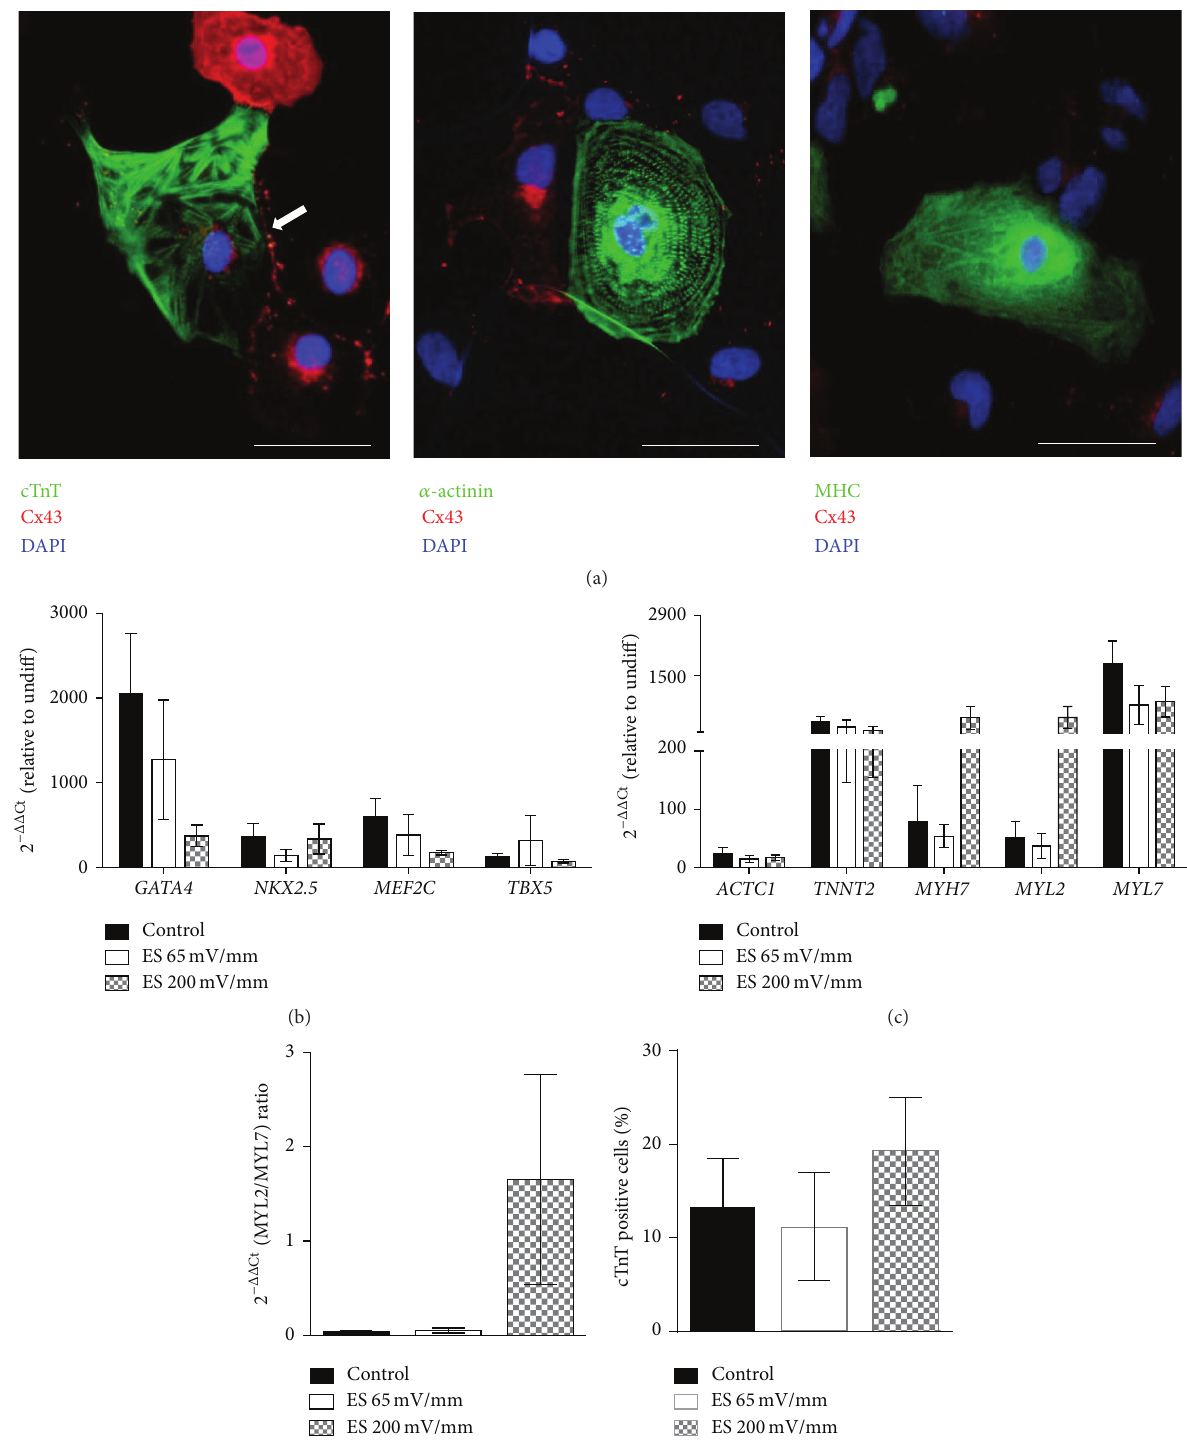
Figure 5: Expression of cardiac-specific markers in cardiomyocytes derived from iPS(Foreskin)-2 cell line. (a) Beating EBs expressed cardiac contractile proteins, cardiac troponin T, sarcomeric 𝛼 -actinin, myosin heavy chain, and gap junctional protein connexin 43 (Cx43, white arrow) (scale bar = 50 𝜇 m). Quantitative RT-PCR analysis for the expression of cardiac transcription factors (b) and cardiac contractile muscle proteins (c) in electrically stimulated and control beating EBs at day 14 after plating ( 𝑛 = 5 –7 independent experiments). (d) MYL2/MYL7 gene expression ratio. (e) Percentage of cardiac troponin T-positive cells in each beating EB at day 14 after plating ( 𝑛 = 5 -6 independent experiments). Data are expressed as mean ± SEM. ES: electrically stimulated and undiff: undifferentiated